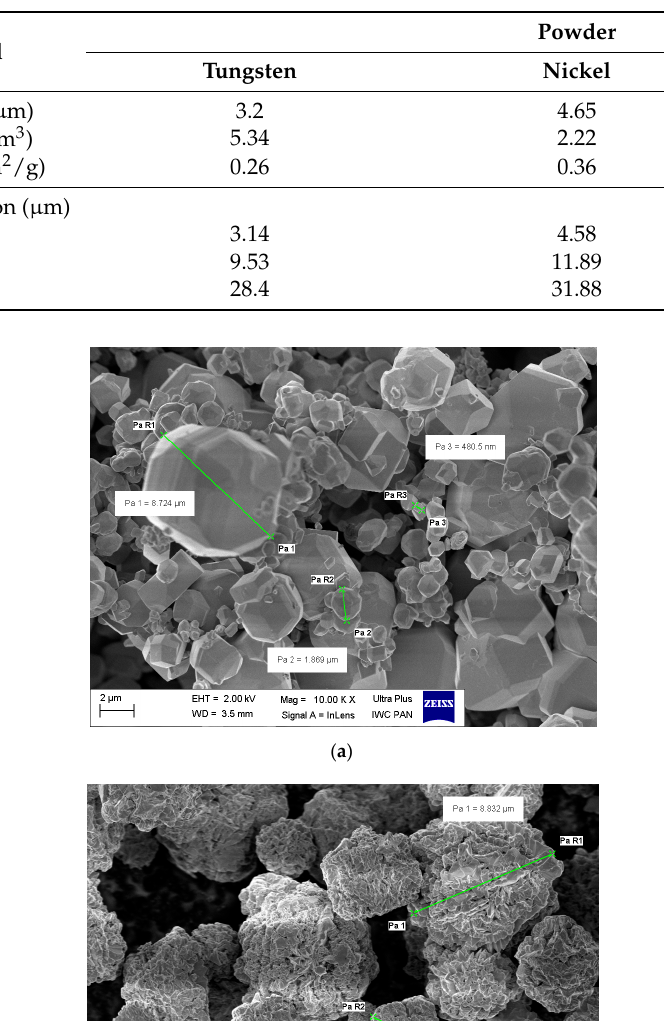
Table 2. The characteristics of powders used for the mixture preparation.